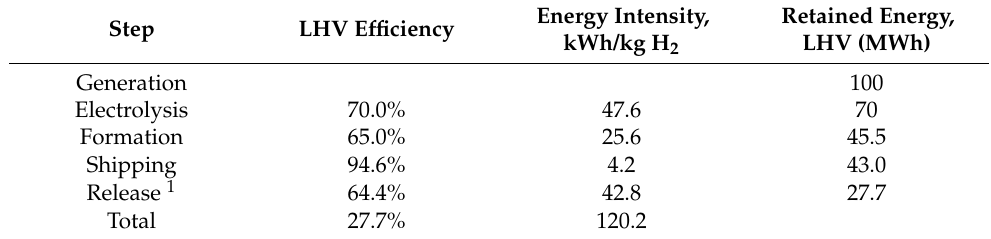
Table 6. Summary of energy efficiency for the various stages in an MCH hydrogen supply chain.